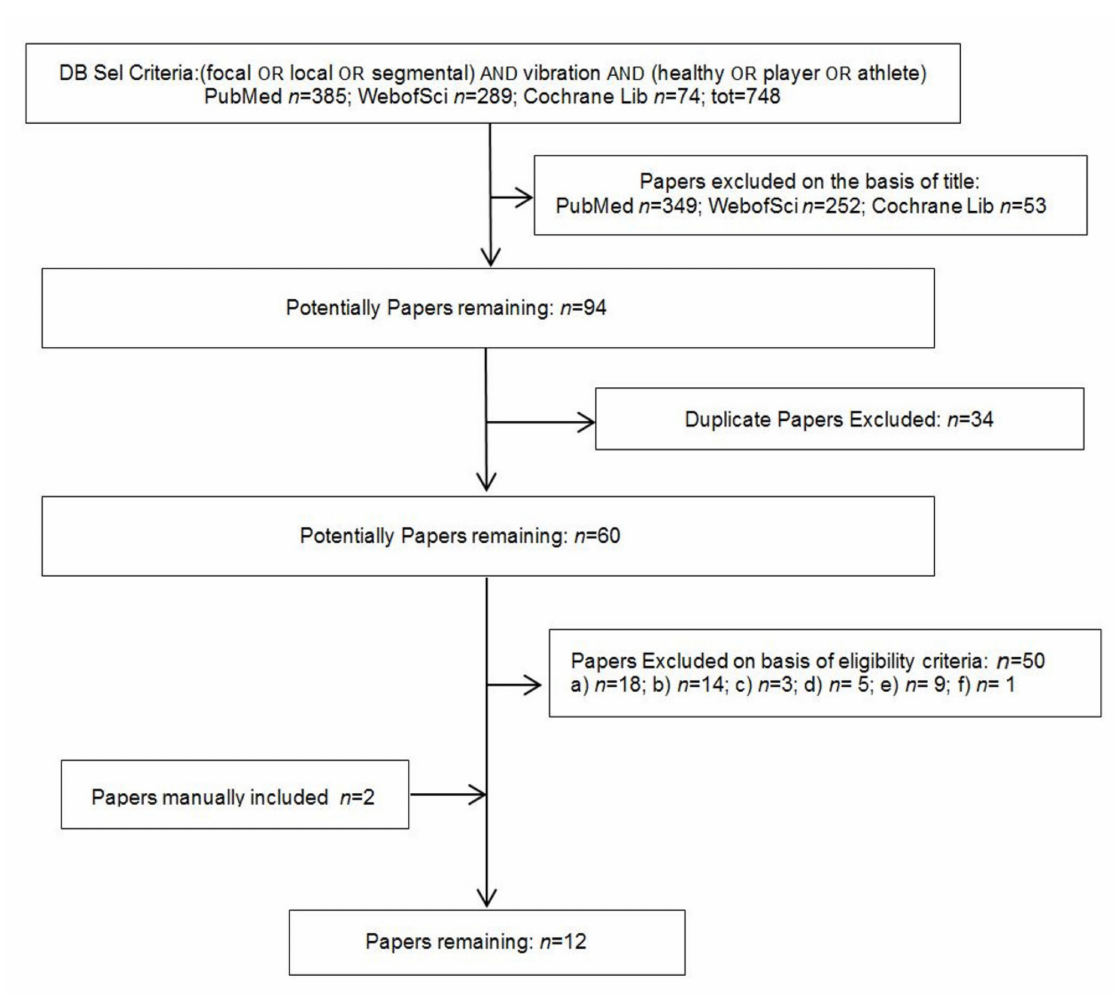
Figure 1. Flow diagram of studies selection